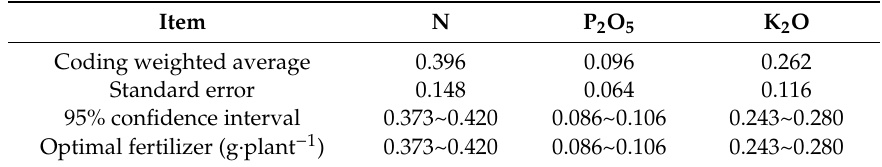
Table 8. Frequency distribution and fertilization scheme of N–P–K encoding values of the seedling quality index (QI) measured at the end of the trial for defining Phoebe bournei seedling growth